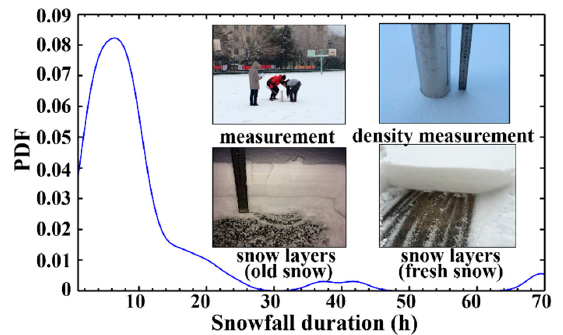
Figure 7. Probability density curve of single snowfall duration, derived from an eight-year field measurement result.